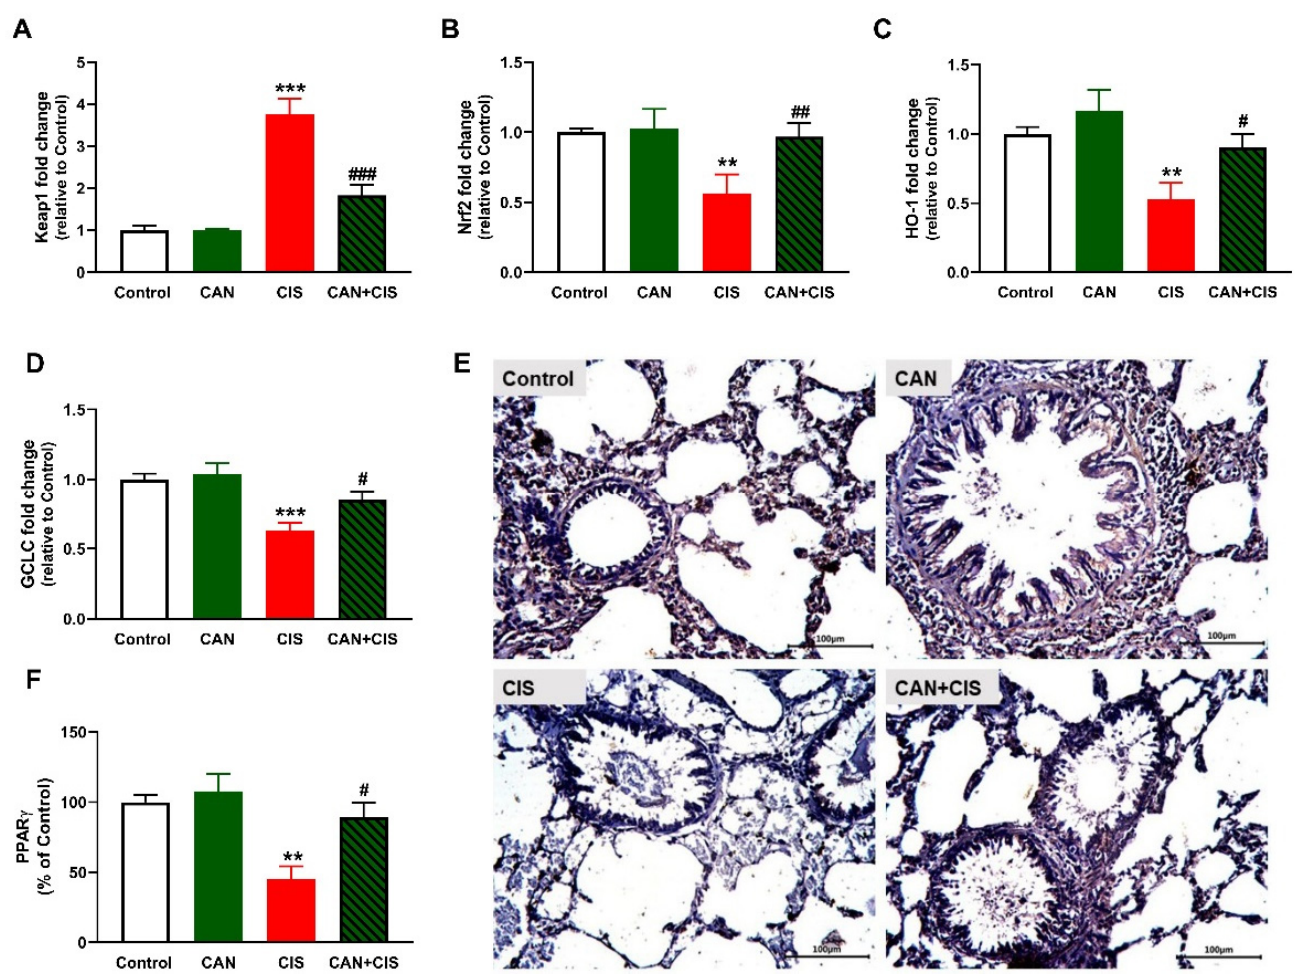
Figure 8. CAN upregulated Nrf2/HO-1 signaling and PPAR γ in CIS-administered rats. CIS de- creased Keap1 ( A ), and increased Nrf2 ( B ), HO-1 ( C ), and GCLC ( D ) mRNA abundance in the lungs of CIS-administered rats. Photomicrographs of the lung sections ( E ) and image analysis ( F ) showed an increase in PPAR γ expression in CIS-administered rats treated with CAN. ** p < 0.01 and *** p < 0.001 versus Control. # p < 0.05, ## p < 0.01 and ### p < 0.001 versus CIS.